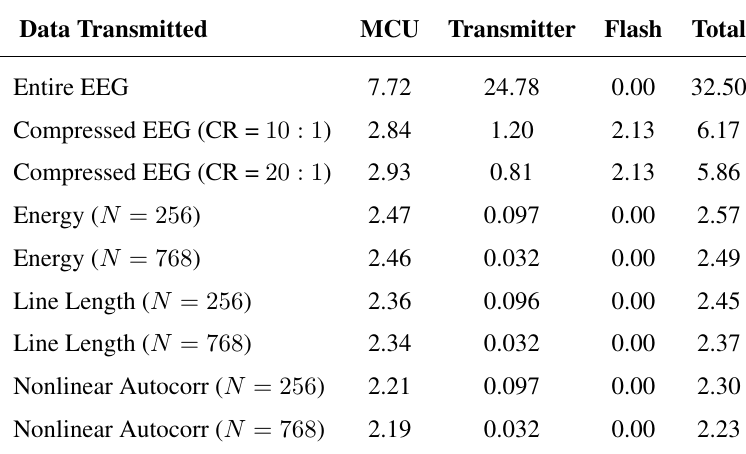
Table 3. Power consumption of different data reduction approaches (in milliwatts). MCU, microcontroller; Nonlinear Autocorr, nonlinear